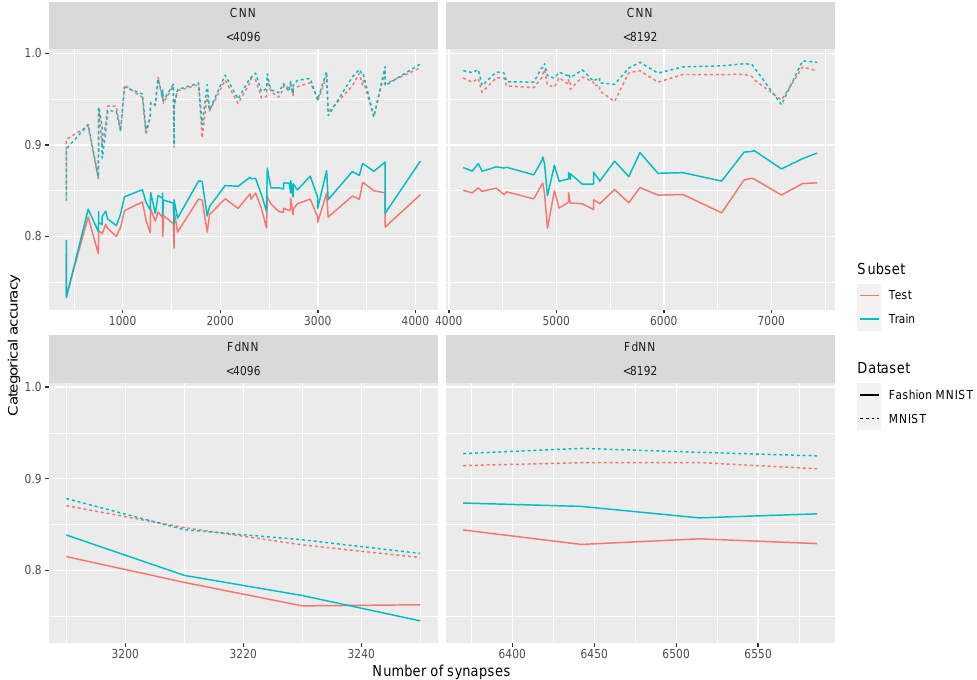
Figure 7. Categorical accuracy obtained for the MNIST and Fashion MNIST datasets in training and test for both FdNN and CNN with different number of synapses categorized in two groups: less than 4096 synapses (1 crossbar array) and in between 4096 and 8192 synapses. Several peaks can be observed due to the different architectures that use similar number of synapses, thus producing different